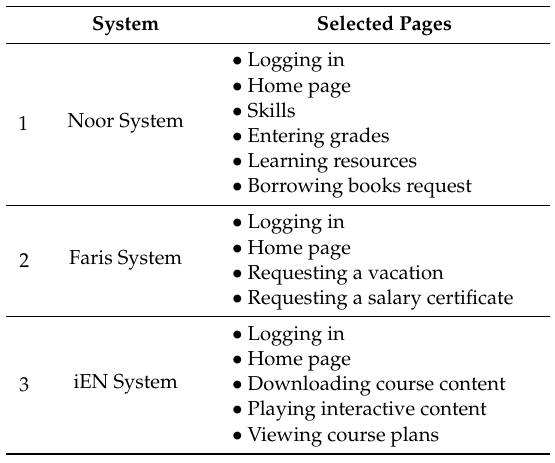
Table 2. Selected pages of the three systems.